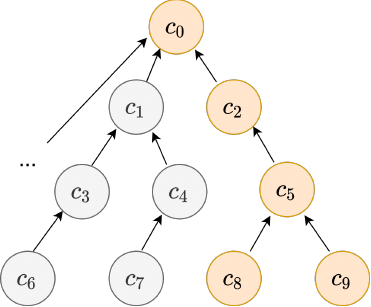
Figure 3. The structure of the medical ontology tree. Table 2. The description of each node in Figure 3. Node ICD-9